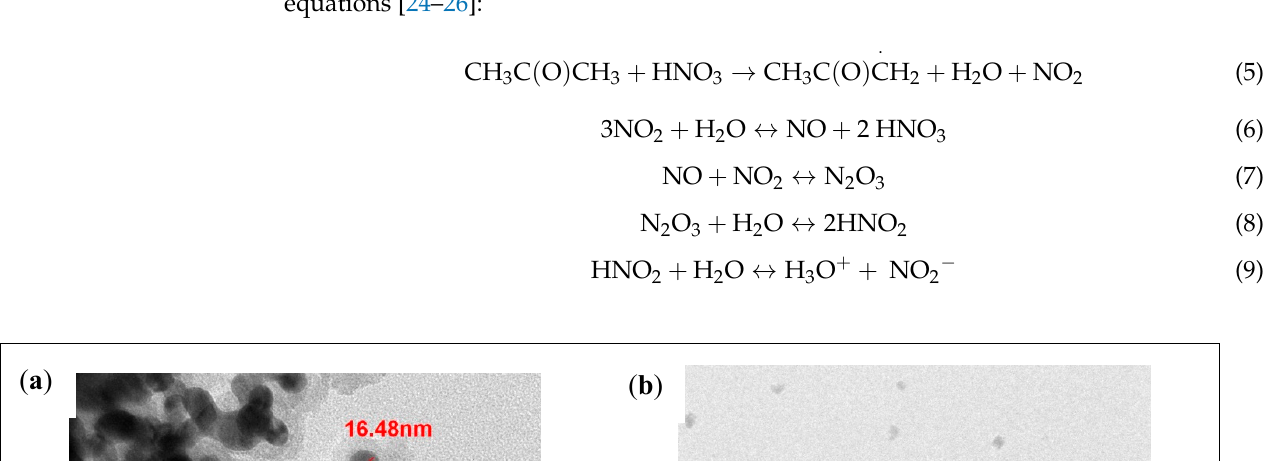
Figure 3. Average diameter and full width at half maximum (FWHM) of GNP solutions obtained at different HNO 3 additions of 30, 50, 70, and 90 μ L within a growth solution.